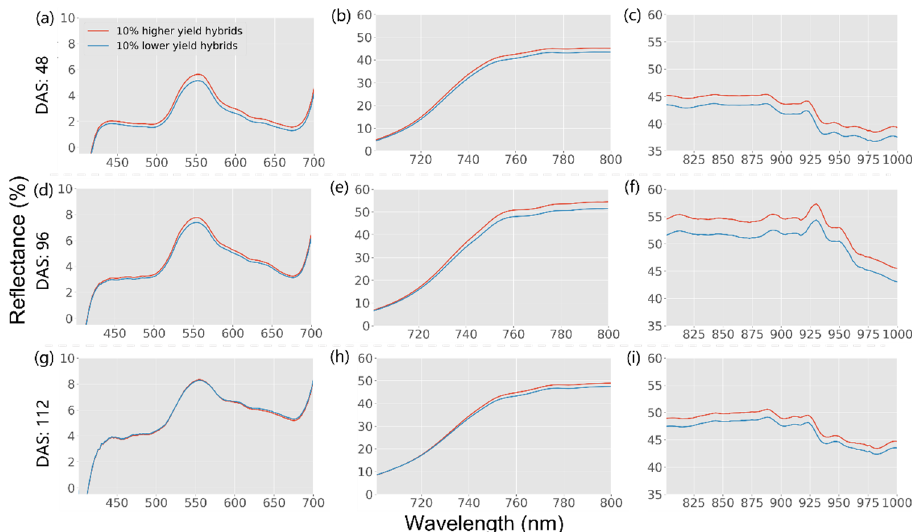
Figure 3. Spectral profiles of the hybrids with the top 10% and bottom 10% yields in the 400–700 nm